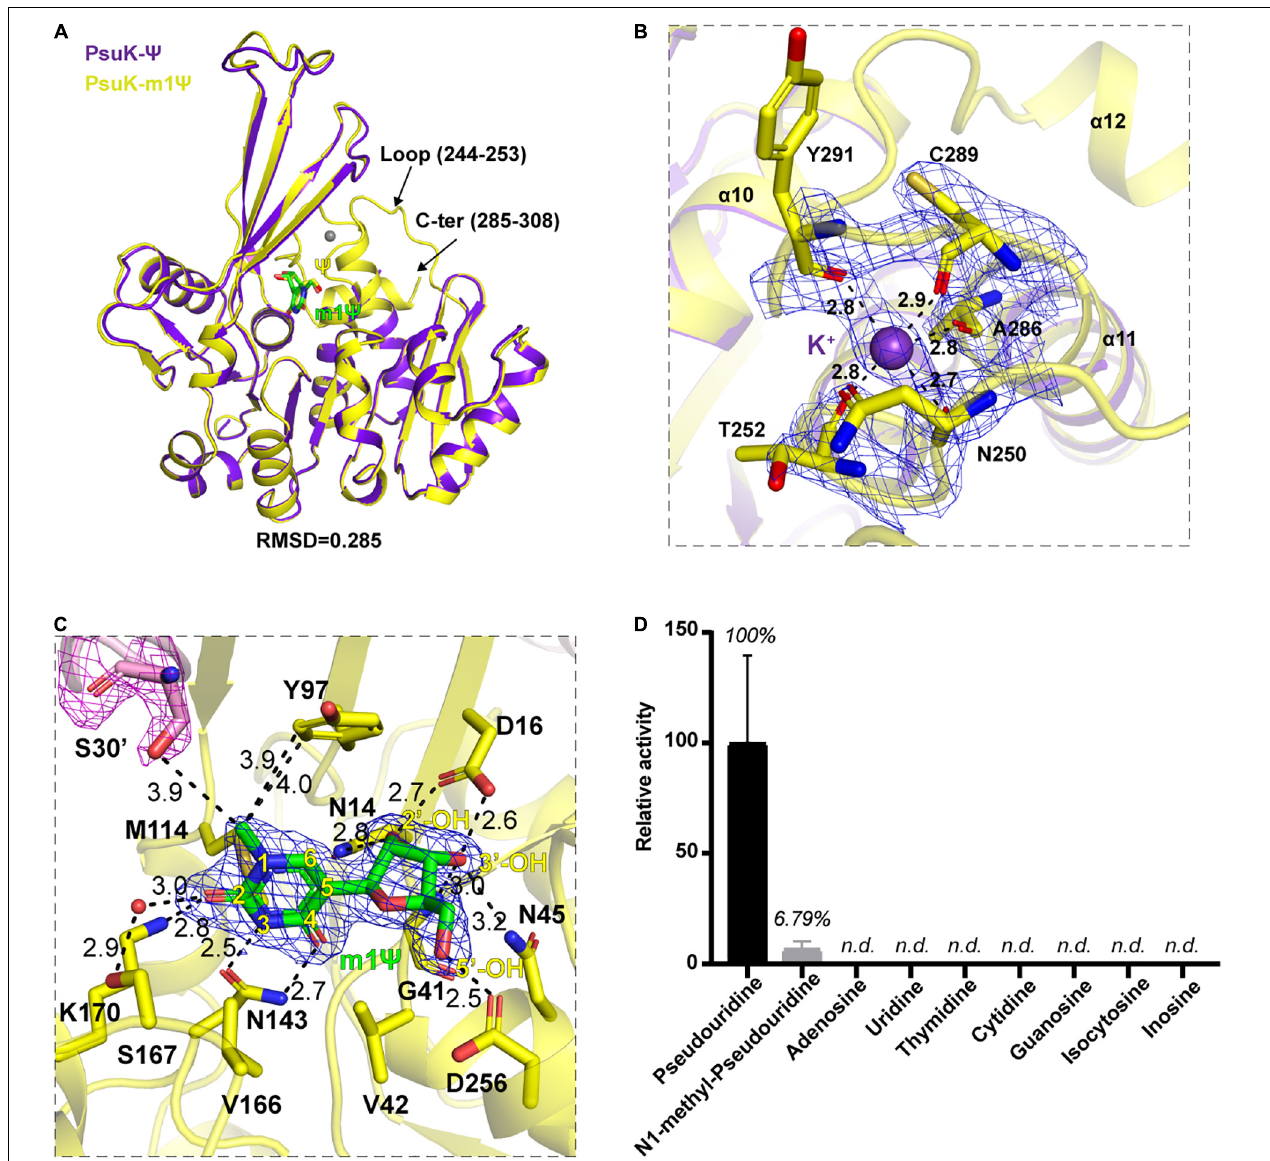
FIGURE 5 | Structure complex of Ec PsuK with m1 (cid:57) . (A) Structure superposition of Ec PsuK-m1 (cid:57) and Ec PsuK- (cid:57) . m1 (cid:57) is colored in green, and (cid:57) is colored in yellow. The lost regions in the Ec PsuK- (cid:57) complex are indicated by black arrows. (B) Binding site of a monovalent ion. The 2| Fo| –| Fc| σ -weighted map is contoured at 1.5 σ . K + is colored purple shown as a sphere. (C) Detailed interactions between Ec PsuK and m1 (cid:57) . Ec PsuK is shown as cartoon and colored in yellow, the residues in contact with (cid:57) are shown as sticks, and m1 (cid:57) is shown as stick colored in green. The hydrogen bonds are shown as black dashed lines. The red sphere represents the water molecule. The 2| Fo| –| Fc| σ -weighted map is contoured at 1.5 σ . (D) Substrate specificity of Ec PsuK for pseudouridine and other nucleoside analogs. n.d., not